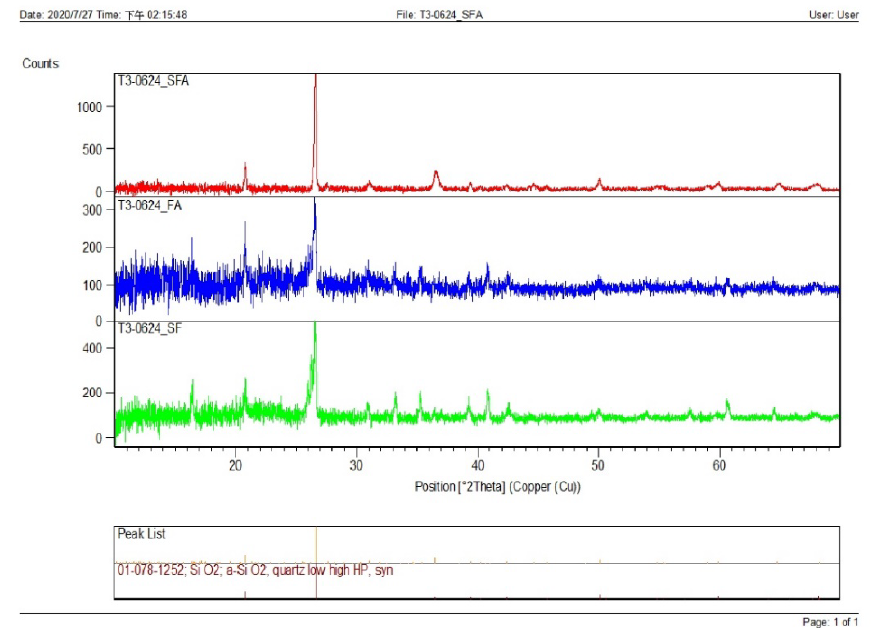
Figure 12. XRD report.